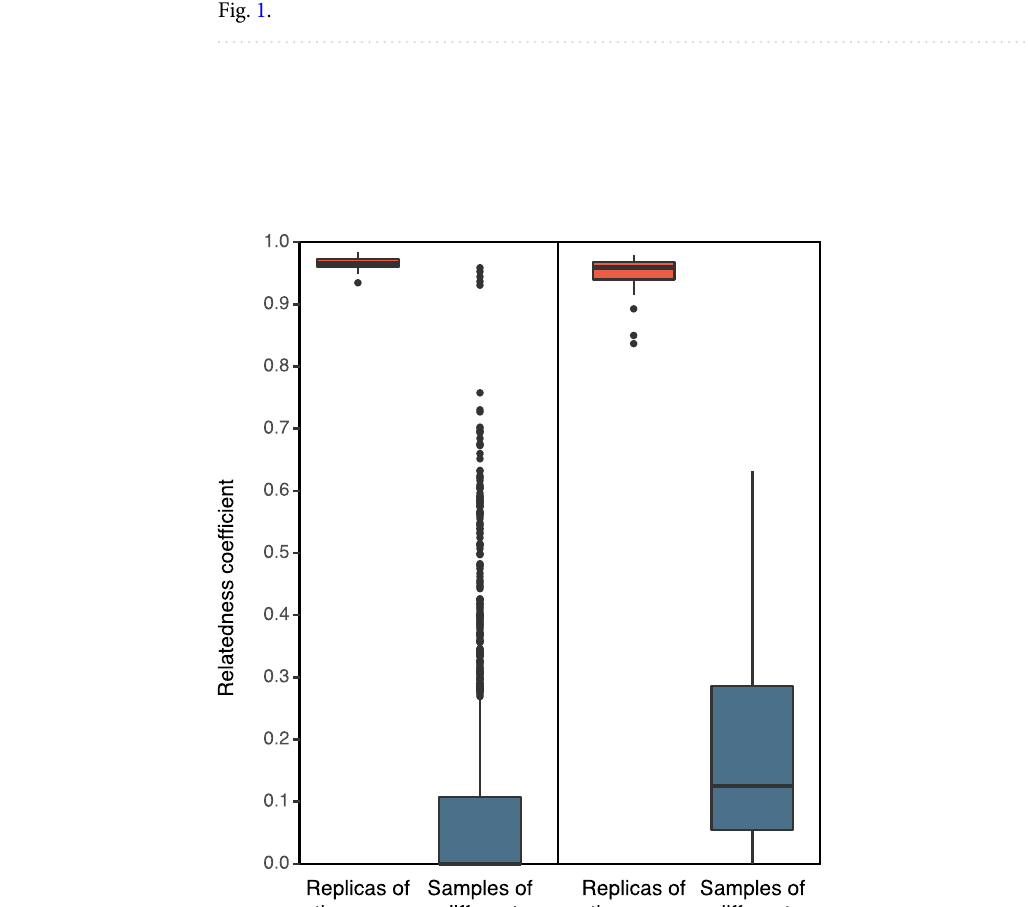
Figure 4. Maps plotting networks of related individuals detected by KING. Line thickness is proportional to the relatedness coefficient of the connected Iberian desmans. The map was constructed as indicated in the legend to Fig. 1.